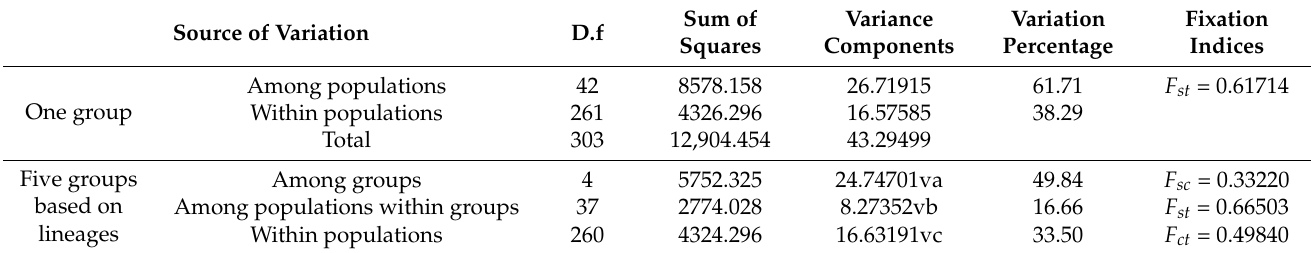
Table 5. AMOVA analysis results of the populations of plateau pika based on the combined